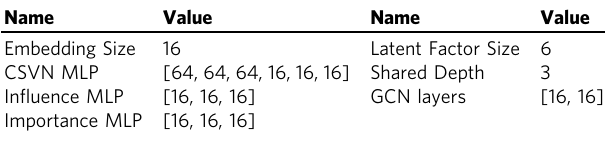
Table 4 The network con fi